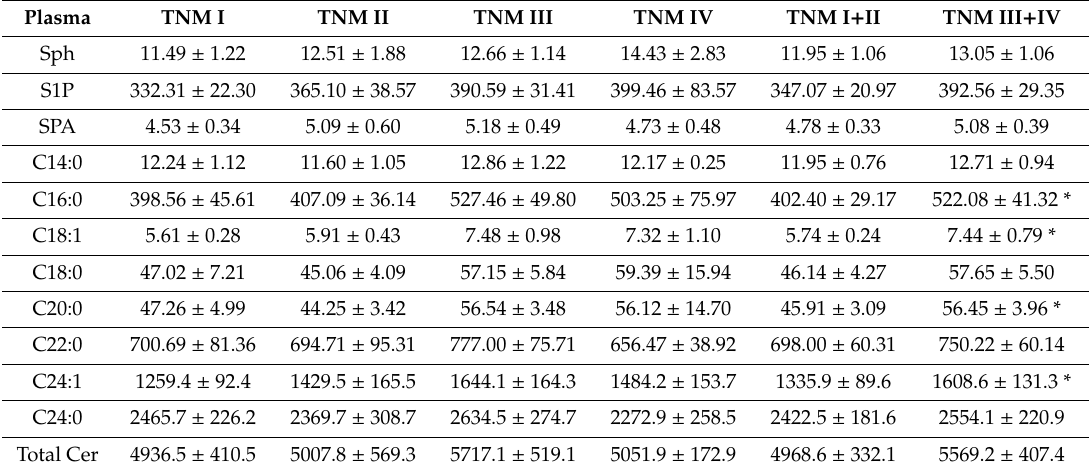
Table 4. Concentration of sphingolipids in the plasma of colorectal cancer patients divided into groups depending on the 8th edition of the TNM classification.